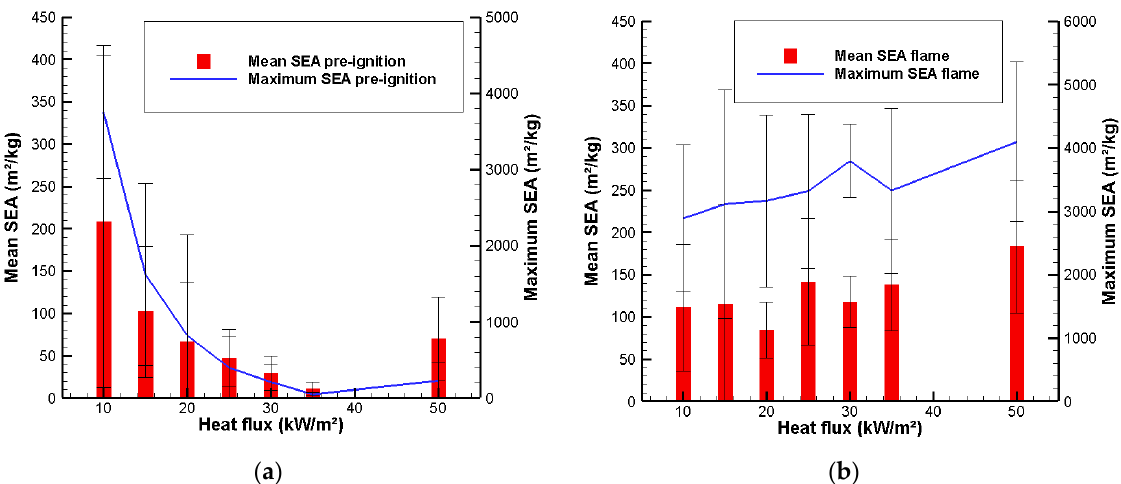
Figure 8. Smoke Extinction Area for an imposed heat flux of 10–50 kW/m 2 for wood samples during ( a ) pre-ignition phase and ( b ) flame phase.